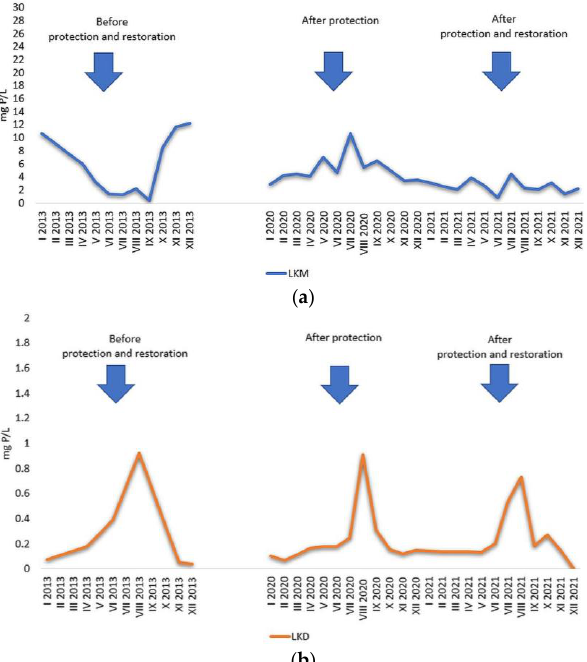
Figure 10. ( a ) Changes in the content of organic phosphorus (P org .) in the bottom water layer of Lake Klasztorne Małe in selected research years. ( b ) Changes in the content of organic phosphorus (P org .) in the bottom water layer of Lake Klasztorne Duże in selected research years.